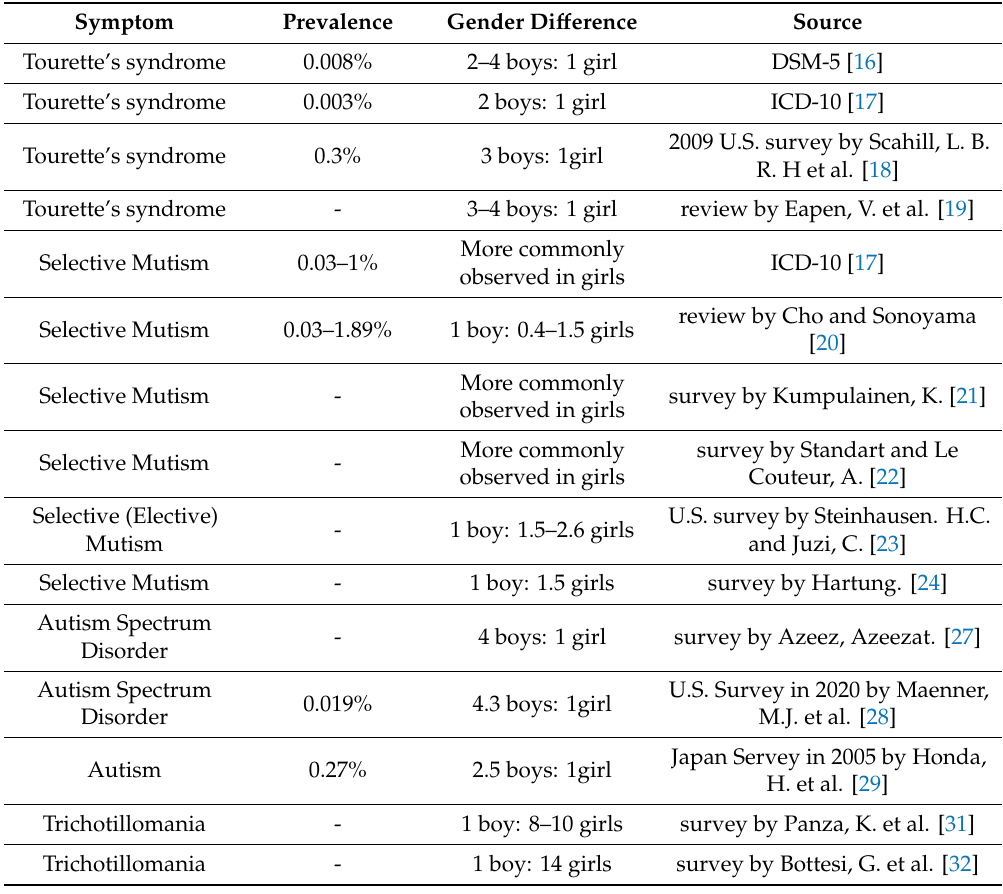
Table 1. Summary of prevalence and gender di ff erences in existing epidemiological